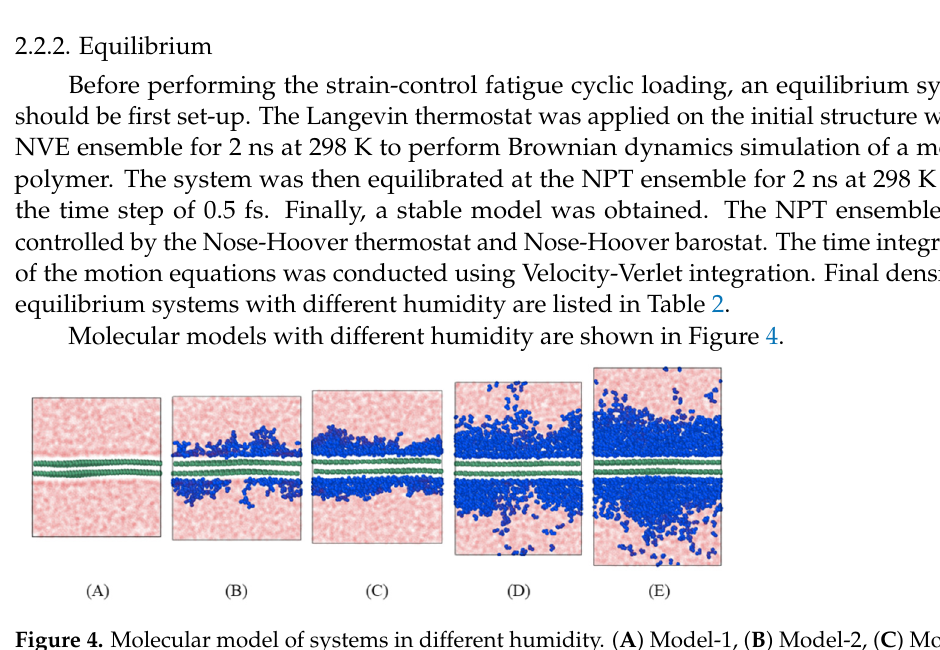
Table 2. Final density of systems with different humidity.